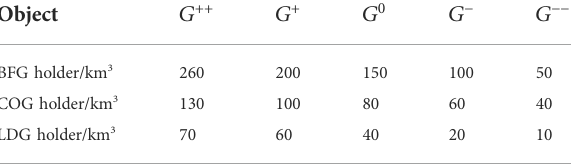
TABLE 1 Position division of the coal gas holder.